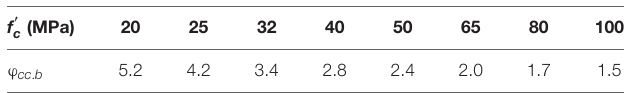
TABLE 1 | Basic creep coefficient in accordance with AS3600.